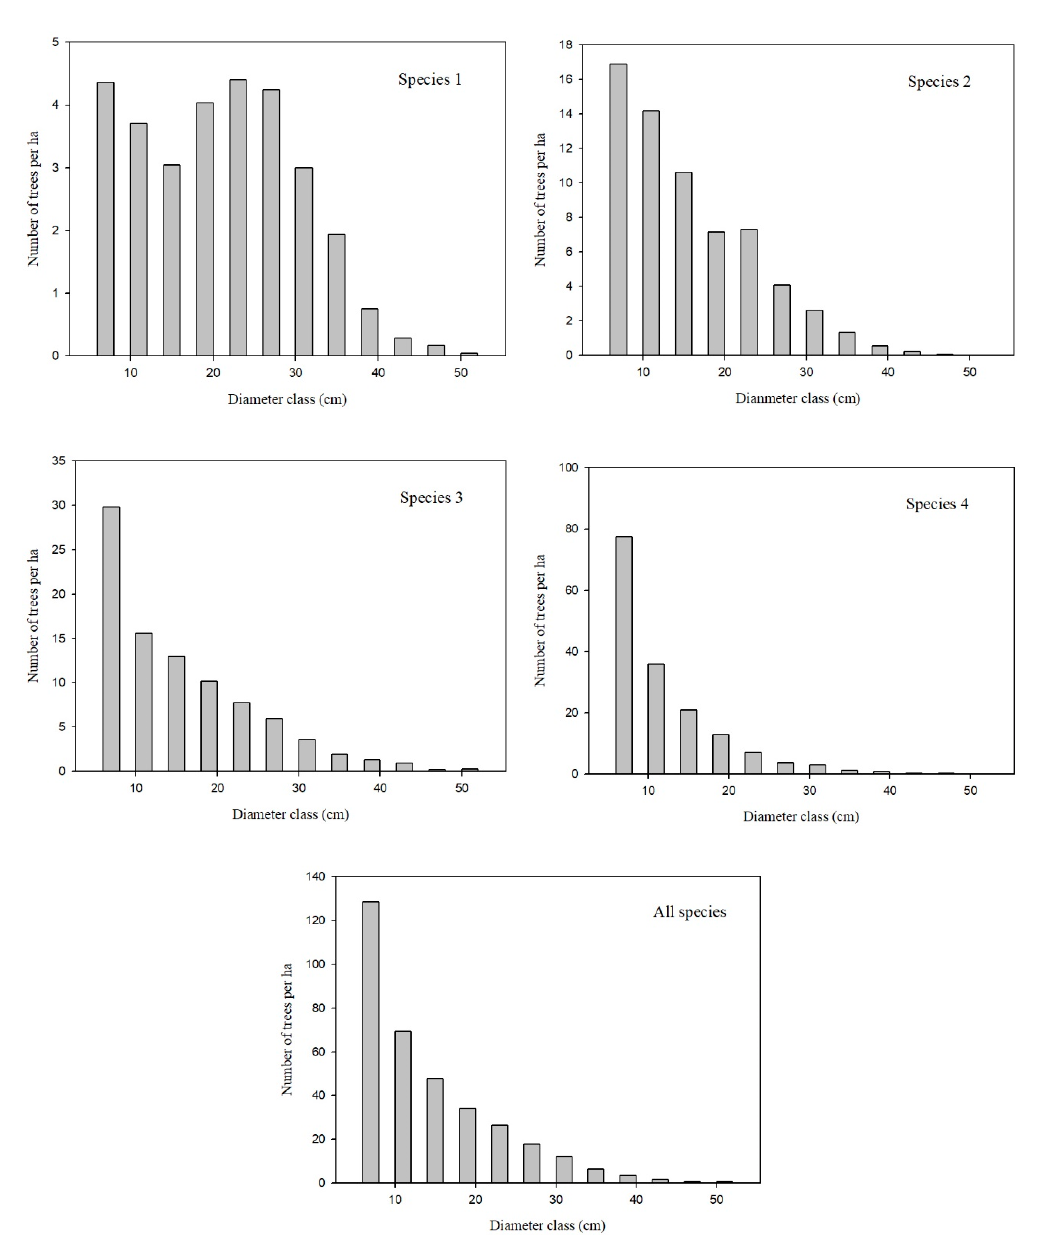
Figure 2. Diameter distributions (4-cm class) of each tree species group for all plots. Note the differences in scale on the y-axis.